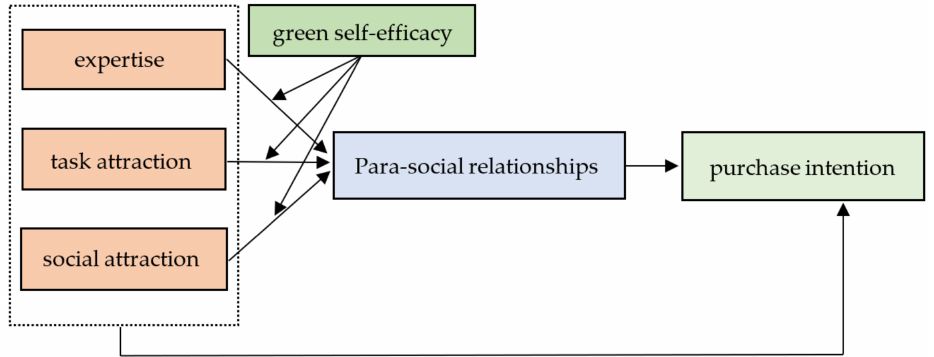
Figure 1. The research framework of intention to purchase energy-saving products.